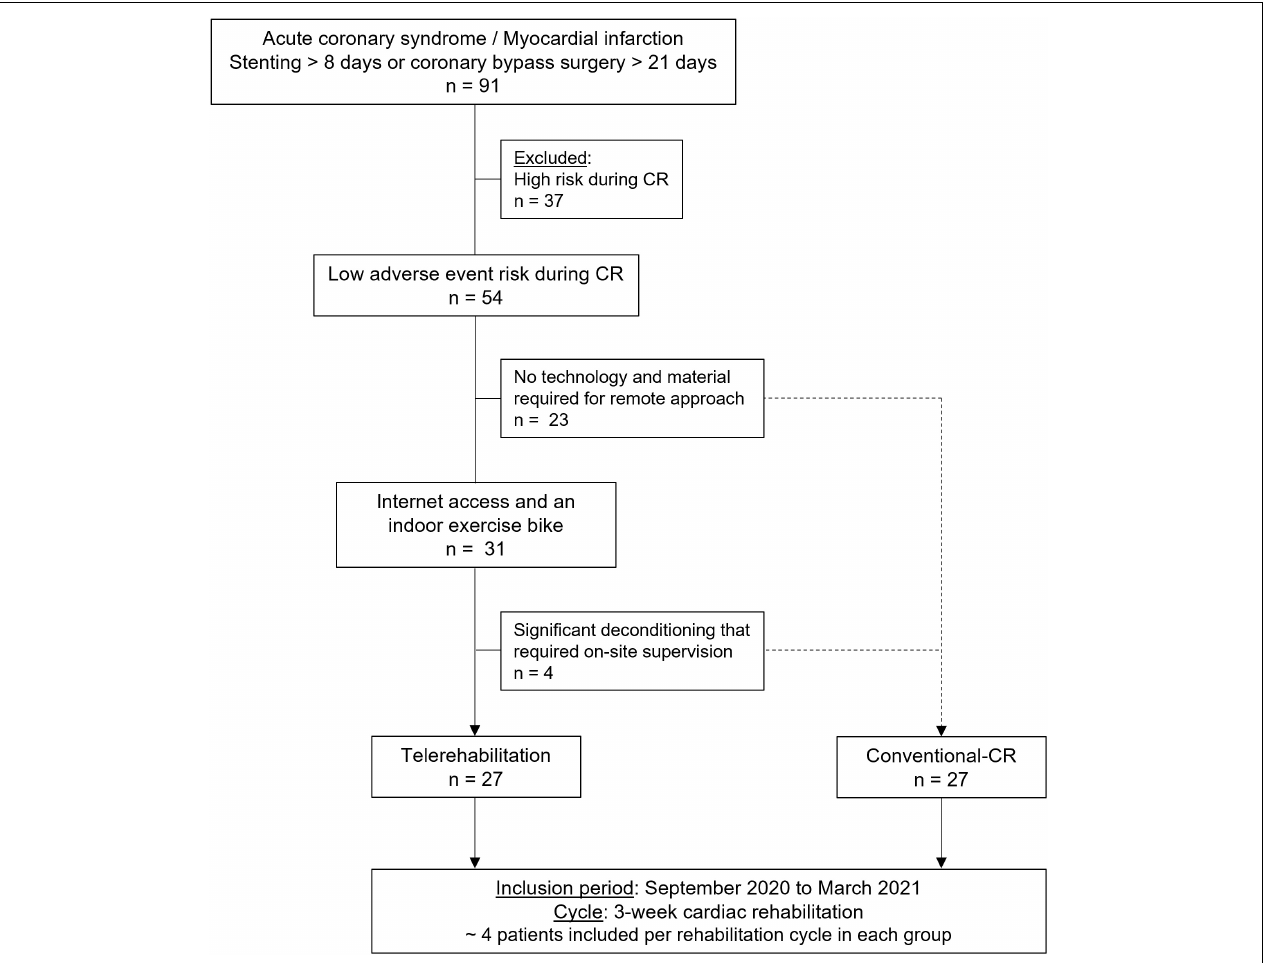
FIGURE 1 | Decision flow chart. CR, cardiac